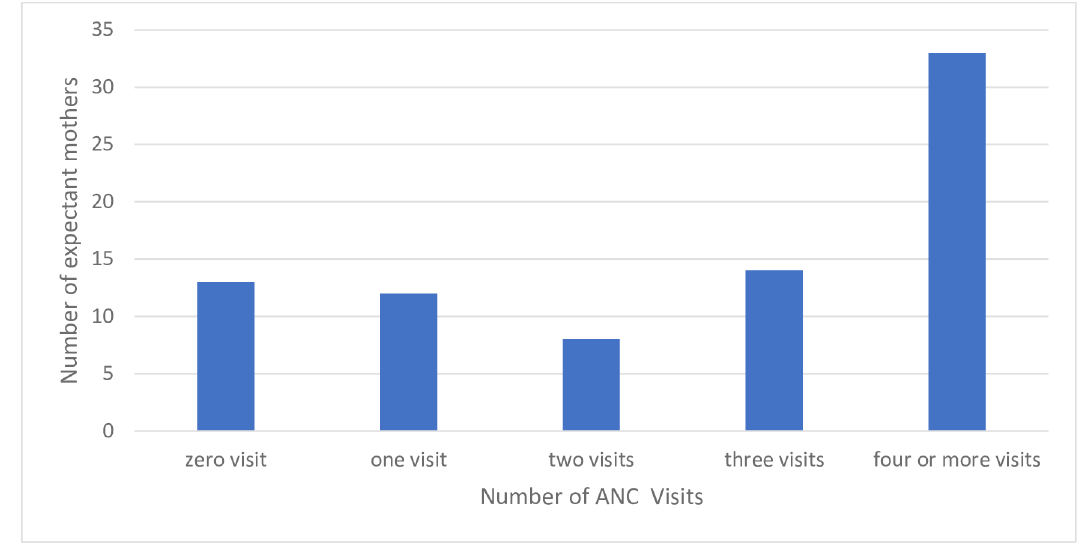
Fig 1. Number of ANC visits in present pregnancy.